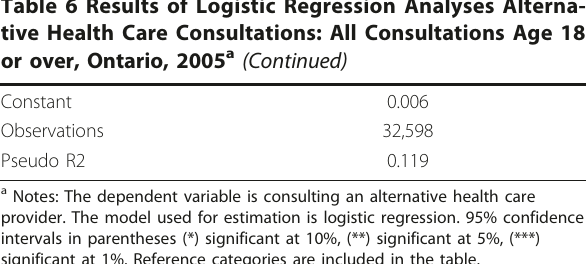
Table 7 shows the results of regression Models 2 to 4.